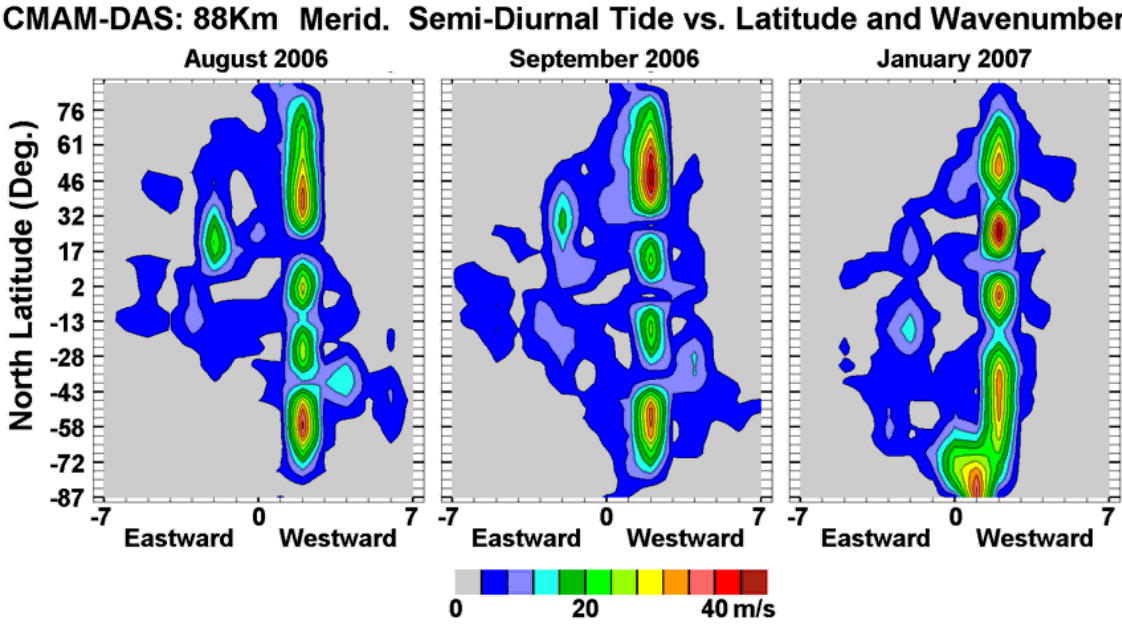
Fig. 11. Spatial spectral analysis from the CMAM-DAS (Canadian Middle Atmosphere Model with Data Assimilation System) for the meridional semidiurnal wind at 88km and for three months (August, September 2006 and January 2007), providing wave number versus latitude contours of amplitude. Positive (negative) numbers represent westward (eastward)